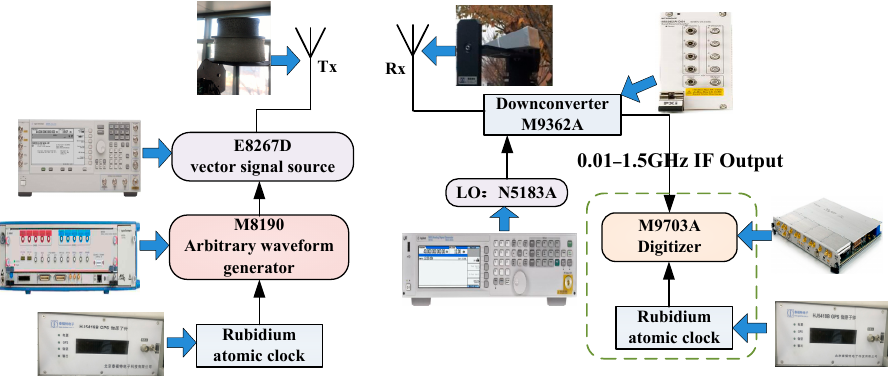
Figure 4. Measurement system used for millimeter waves.